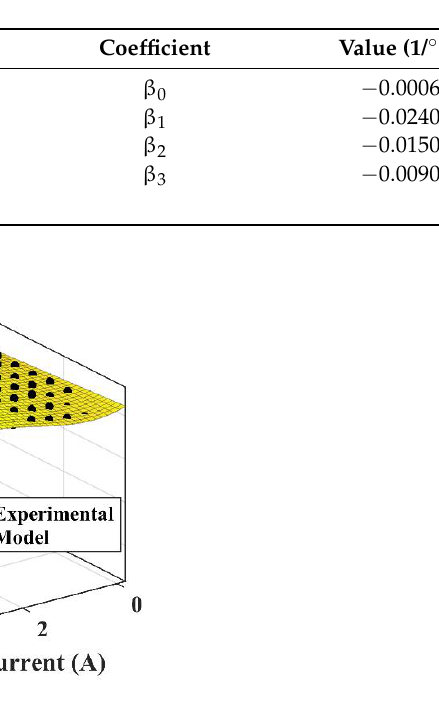
Figure 3. Comparison of experimental points obtained from inductor characterization with model